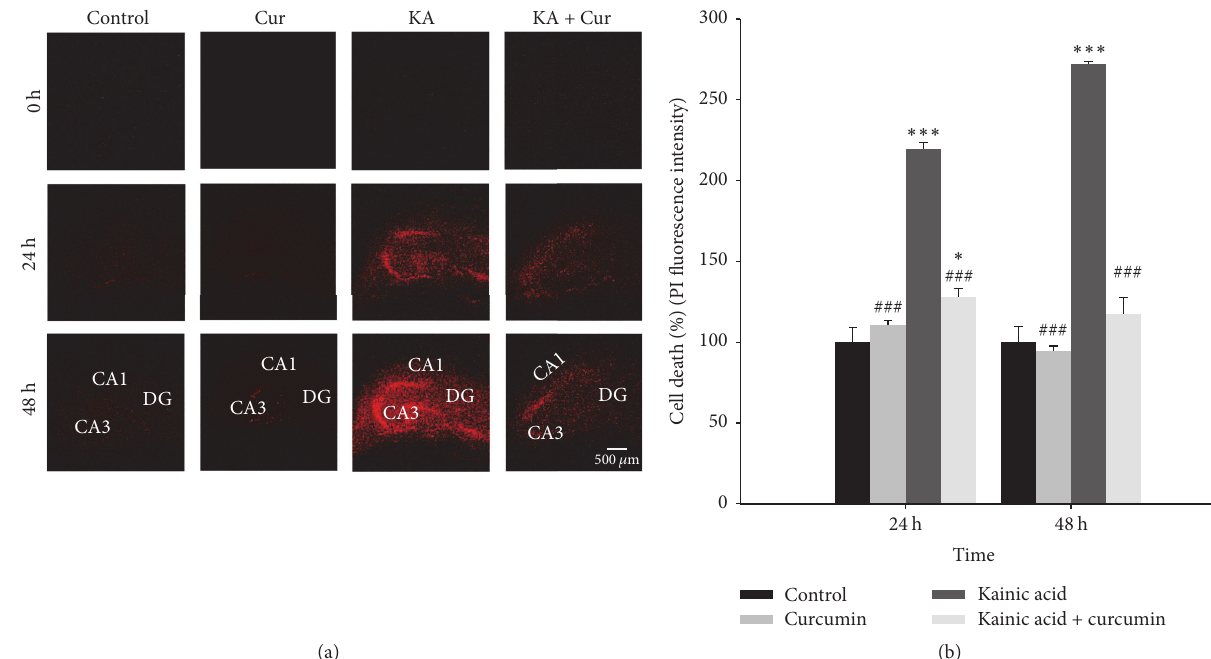
Figure 3: Detection of neuronal cell death in organotypic hippocampal slice cultures (OHSCs) with kainic acid (KA) and curcumin treatment by propidium iodide (PI) staining. OHSCs were treated with 10 𝜇 M curcumin and 5 𝜇 M KA. (a) Representative images of PI uptake in OHSCs. RedrepresentsPIfluorescence,whichindicatescellmembranedamage.Scalebar=500 𝜇 m.(b)Quantificationofhippocampalcelldeath.Data are shown as the percentage cell death. The fluorescence intensity of the control group was designated as 100%. Differences in PI fluorescence intensities among control, control + curcumin only, KA-only-treated group, and KA with curcumin groups were observed by fluorescence microscopy. The PI value is shown as mean ± SEM. Four hippocampal slices were used in each group. ∗ 𝑝 < 0.05 , ∗∗∗ 𝑝 < 0.001 versus control group. ### 𝑝 < 0.001 versus the KA-only-treated